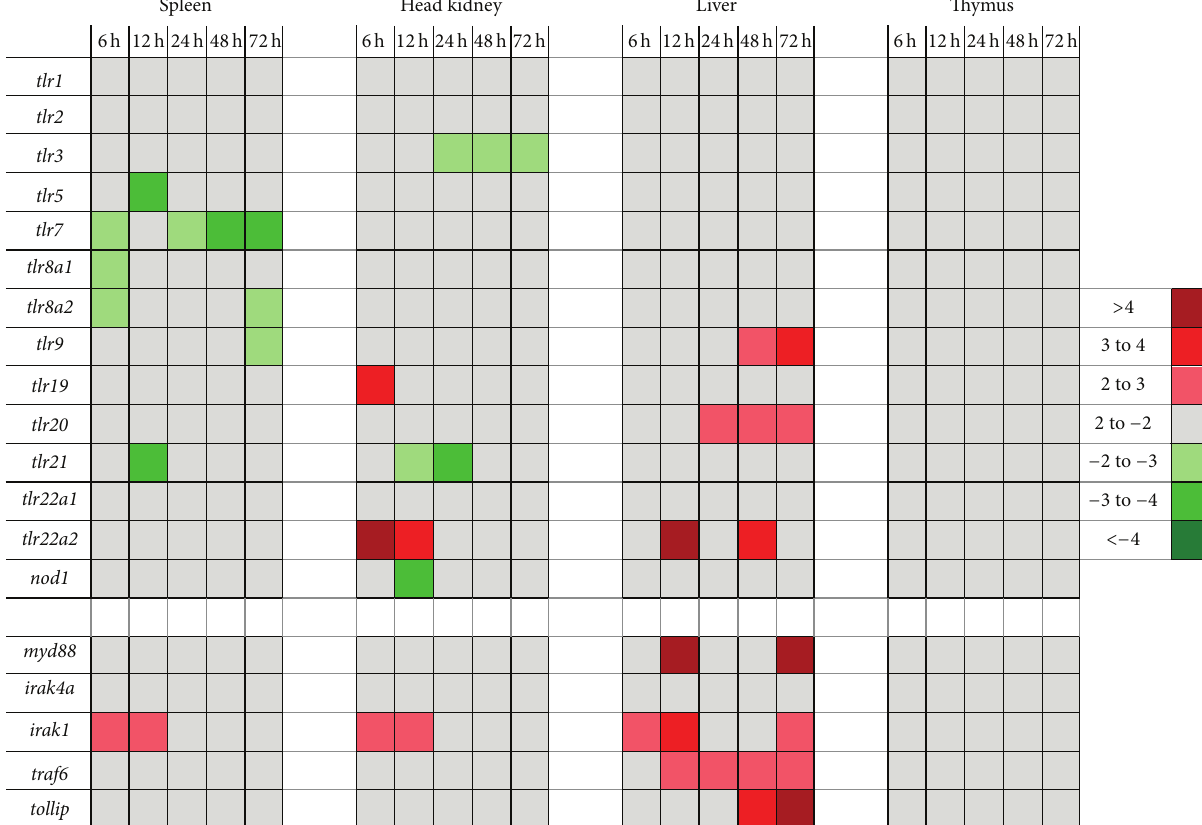
was conceivably triggered by the induced expression of key